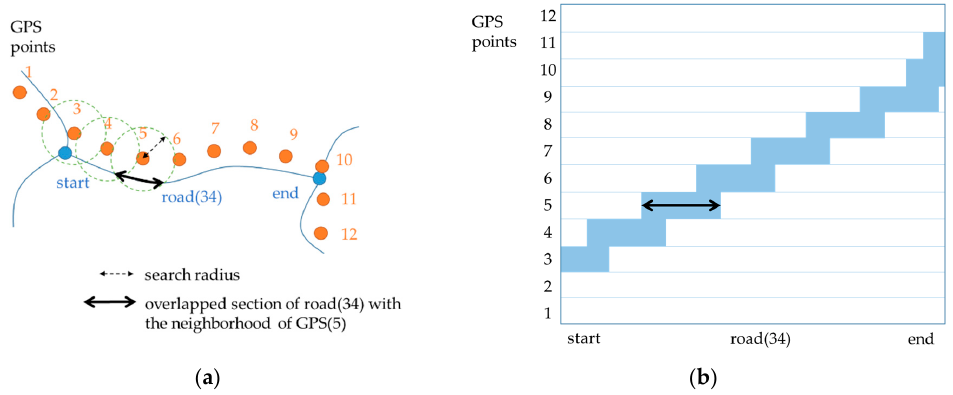
Figure 5. An example of ( a ) GPS signal and a road segment and ( b ) a free-space diagram from the example. For example, an element of the free space at the 5th GPS point is depicted as a bar corresponding to an overlapped section of the road segment and a search range of the point.